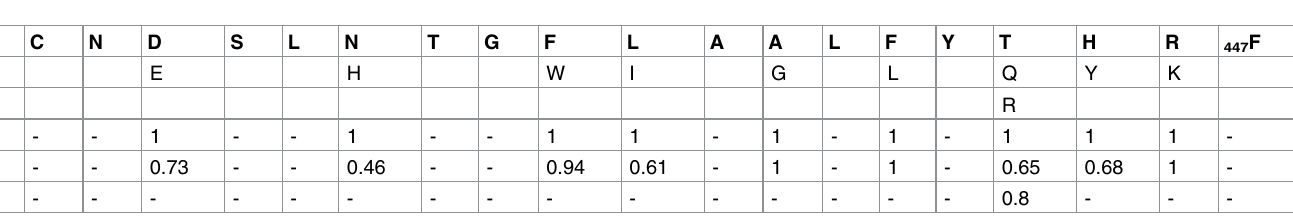
Table 7. Tolerance to the amino acid substitution in the epitopes targeted by VF-Fab1b-1-3.